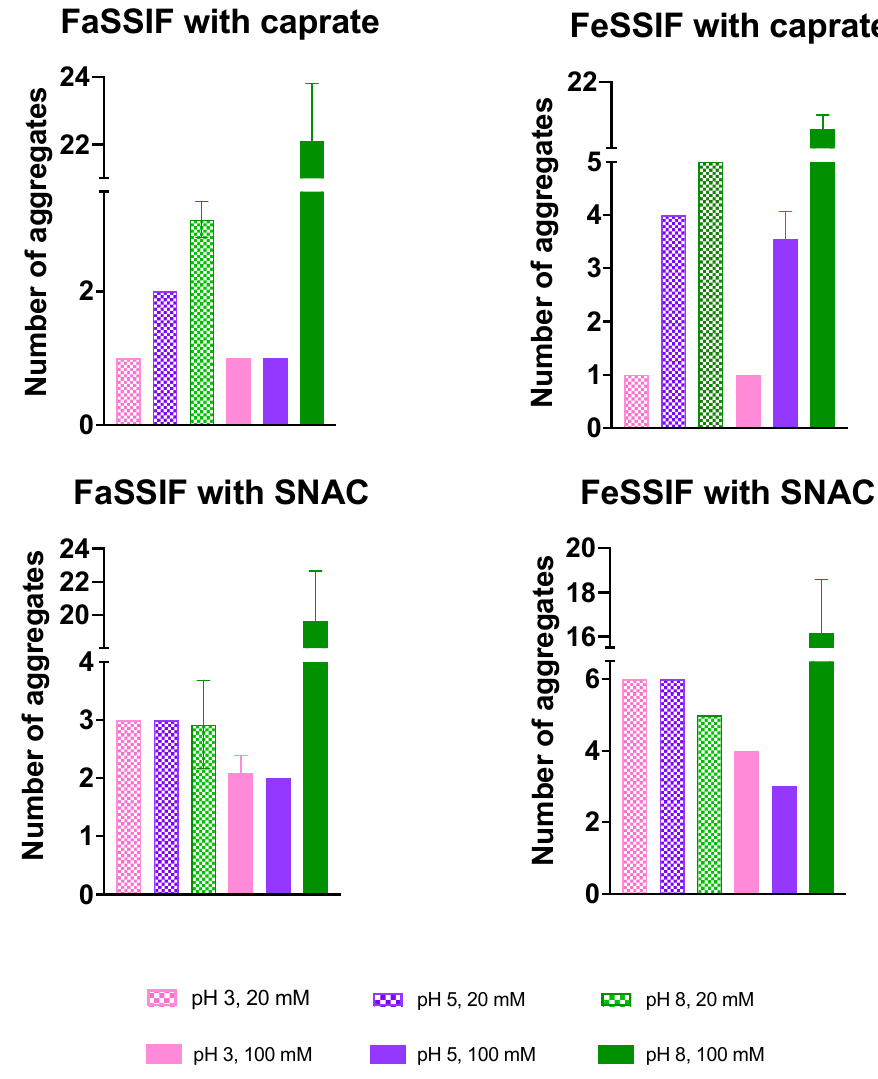
Figure 5. Number of aggregates for all studied systems, presented as an average value and standard deviation calculated using the last 200 ns of the simulation trajectory. A number of systems contained a constant number of aggregates during the last 200 ns of the simulation and hence no error bars were available for those systems.